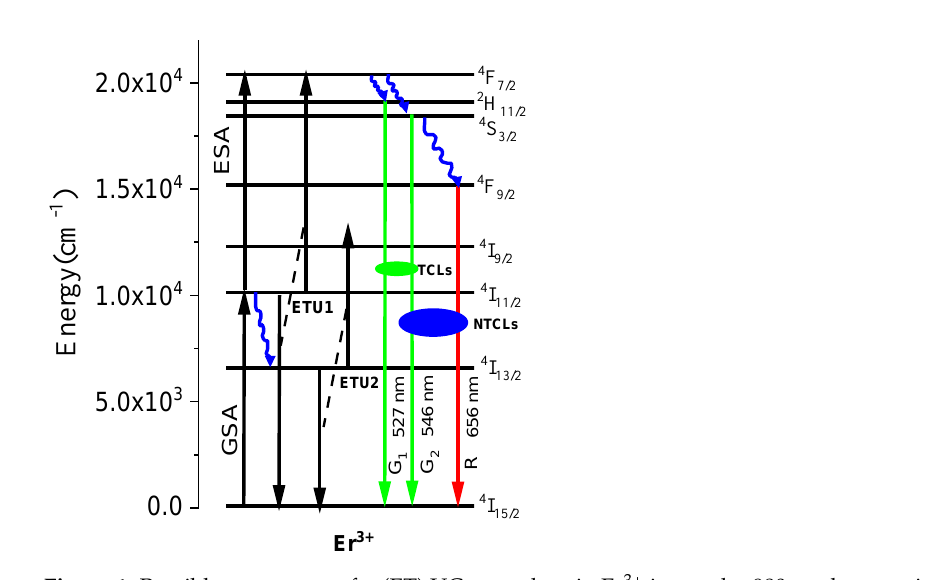
Figure 1. Possible energy transfer (ET) UC procedure in Er 3+ ion under 980 nm laser excitation. The most common mechanism for red UC is a nonradiative transition from the 2 H The energy gap ΔE between the 2 H 11/2 and 4 S 3/2 levels and the pre-exponential constant C can usually be calculated using one of two approaches: (1) intensity ratio of 2 H 11/2 and 4 S 3/2 levels (FIR) can be plotted against absolute temperature ( T ) and fitted by exponential